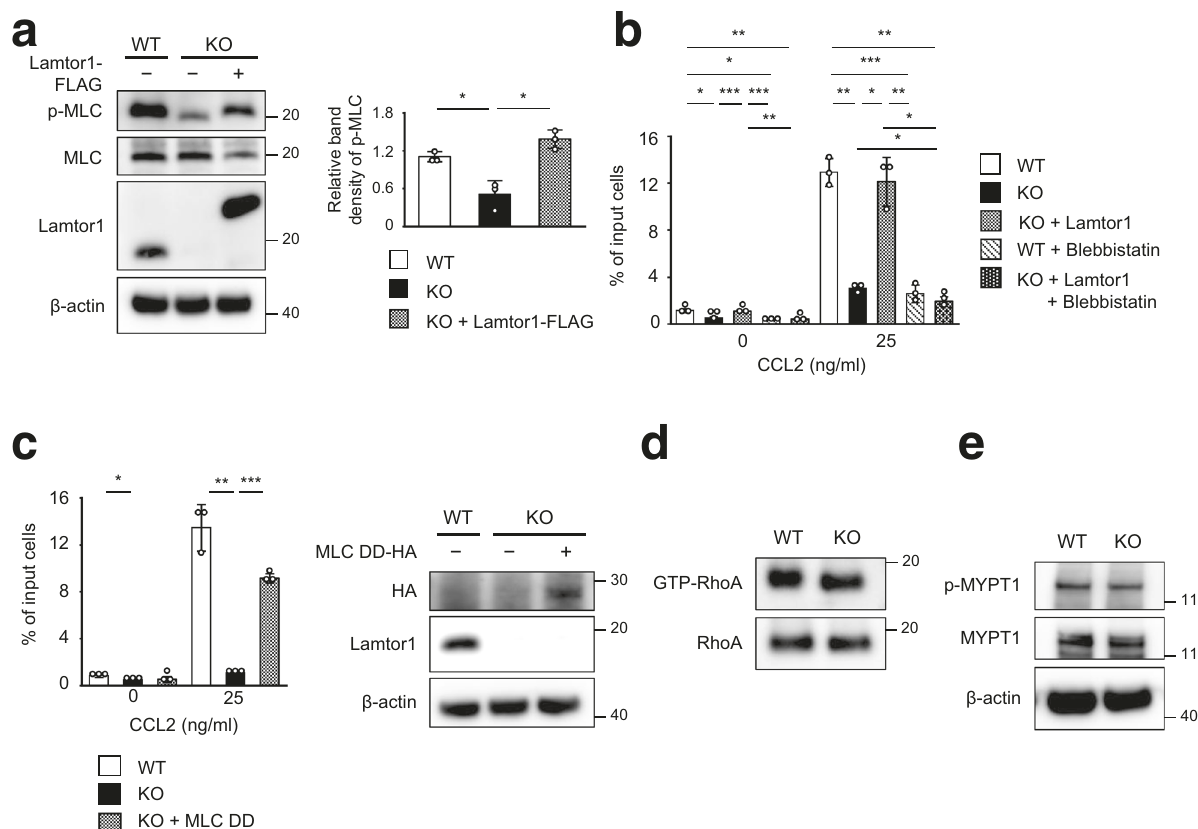
Fig. 6 Lamtor1-mediated motility is driven by Myosin II activity. a MLC phosphorylation in the presence or absence of Lamtor1. WT-THP1, Lamtor1 -KO- THP1, and Lamtor1 -KO-Full-THP1 cells were lysed, and MLC phosphorylation was detected by western blotting with anti-p-MLC antibody (left). The concentration of p-MLC of WT-THP1 (white bar), Lamtor1 -KO-THP1 (black bar), and Lamtor1 -KO-Full-THP1 (mesh bar) in SDS-PAGE gel bands was determined using ImageJ, and statistical analysis was performed (right). b , c Myosin II-dependent Lamtor1-mediated motility. Chemotaxis of WT-THP1 (white bar), Lamtor1 -KO-THP1 (black bar), Lamtor1 -KO-Full-THP1 (mesh bar), blebbistatin-treated WT-THP1 (diagonal bar), and blebbistatin-treated Lamtor1 -KO-Full-THP1 (dark mesh bar) in response to 25 ng/ml CCL2 was determined by Transwell assay (pore size, 5 μ m) ( b ). Chemotaxis of WT-THP1 (white bar), Lamtor1 -KO-THP1 (black bar), and Lamtor1 -KO-THP1 expressing MLC-DD-HA, a constitutively active form of MLC (mesh bar) in response to CCL2 were evaluated by a Transwell assay (pore size, 5 μ m) (left). Expression of MLC-DD-HA in Lamtor1 -KO-THP1 was evaluated by western blotting using an anti-HA antibody (right) ( c ). d Active form of RhoA in WT and Lamtor1 − / − BMDCs. Cells were lysed, and GTP-bound RhoA was pulled down with GST-Rhotekin-RBD and detected by western blotting with an anti-mouse RhoA antibody. e MYPT1 phosphorylation in WT and Lamtor1 − / − DCs. WT and Lamtor1 − / − BMDCs were lysed and phosphorylated MYPT1 was evaluated by western blotting with an anti-p-MYPT1 antibody. Statistical analysis was performed by two-sided ANOVA with Tukey ’ s post hoc test ( a – c ) [means ± s.d.; *p < 0.05, **p < 0.01, ***p < 0.001]. Data are representative of three